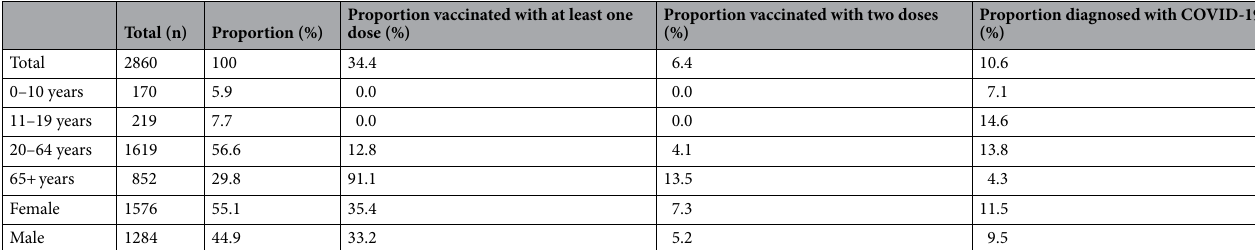
Proportion vaccinated with two doses (%)